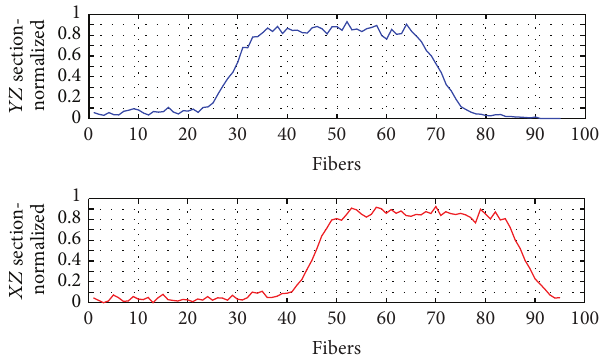
Figure 22: Beam profiles monitored during time by the OFFSET